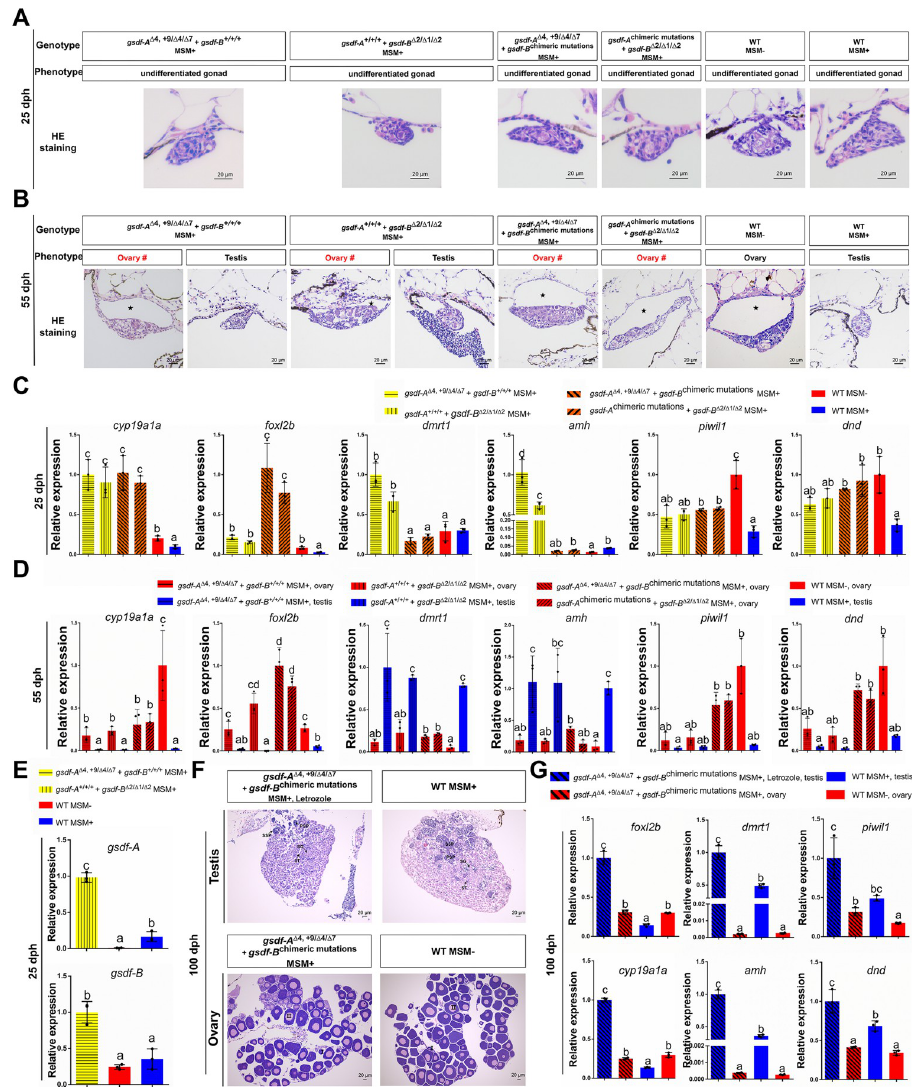
Fig 5. Aromatase inhibitor treatment rescues the male-to-female sex reversal in gsdf mutants. (A-B) Gonadal histology of different gsdf mutants and wild type individuals at 25 (A) and 55 dph (B) . dph, days post hatching; #, sex reversal; star symbol, ovarian cavity; MSM+, with MSM; MSM − , without MSM; WT, wild type. (C-D) Gonadal gene expression of different gsdf mutants and wild type individuals at 25 (C) and 55 dph (D) , including female marker genes cyp19a1a and foxl2b , male marker genes dmrt1 and amh , and primordial germ cell marker genes piwil1 and dnd . (E) Gsdf-A compensatory expression in the gonads of gsdf-B mutants and gsdf-B compensatory expression in the gonads of gsdf-A mutants at 25 dph. (F-G) Gonadal histology (F) and gene expression (G) of gsdf-A / gsdf-B double mutant individuals ( gsdf-A Δ 4,+9/ Δ 4/ Δ 7 + gsdf-B chimeric mutations , MSM+), gsdf-A / gsdf-B double mutant individuals ( gsdf-A Δ 4,+9/ Δ 4/ Δ 7 + gsdf-B chimeric mutations , MSM+) with aromatase inhibitor (Letrozole) treatment, and wild type individuals at 100 dph. Different letters represent statistical differences ( P < 0.05). The highest expression level in each qPCR analysis was used as control and defined as 1. Although gonads at 25 dph could not be distinguished as ovaries or testes by morphological analysis, the expression levels of marker genes in the gsdf mutants, especially the gsdf-A / gsdf-B double mutants, could provide clues to sexual fate (Fig 5C and 5D). The gonadal aromatase gene cyp19a1a is a conserved factor of ovarian differentiation in fish [58,59] and also has been